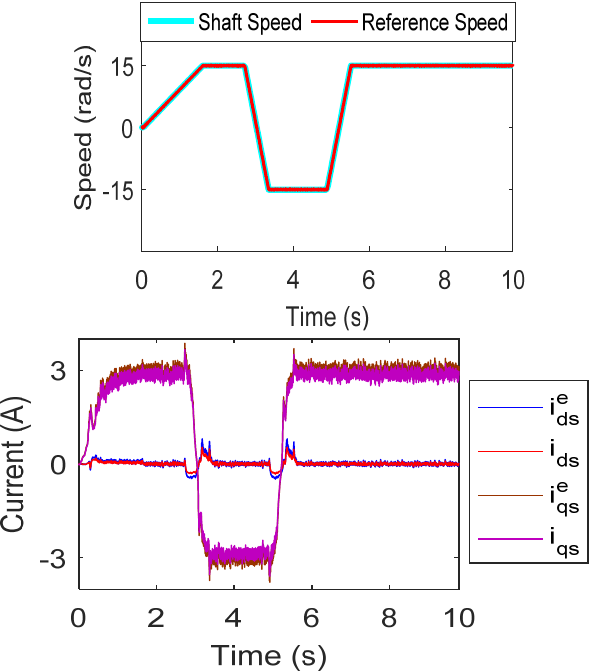
Figure 12. Experimental results for the forward and reverse motoring with a ramp speed command.